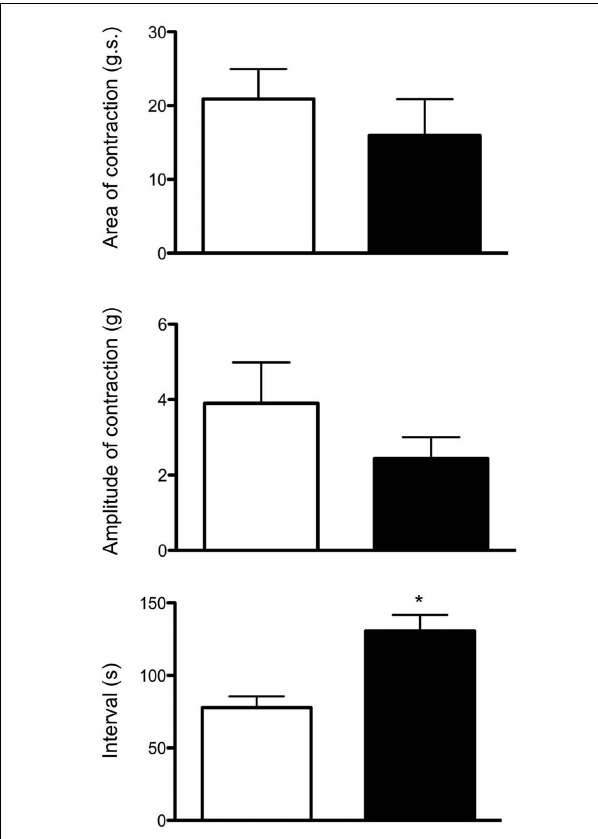
FIGURE 4 | Similarities between CMMCs evoked in intact colons compared with those evoked in mucosa and submucosal plexus-free colons. The area-under-contraction and amplitude of evoked CMMCs was no different between either preparation. Interestingly, the threshold levels of circumferential stretch (in mm) required to evoked CMMCs was actually lower in preparations that had had their mucosa and submucosal plexus removed ( N = 5; P < 0.05).White boxes refer to control colon, while black bars refer to mucosa and submucosal plexus-free colons.